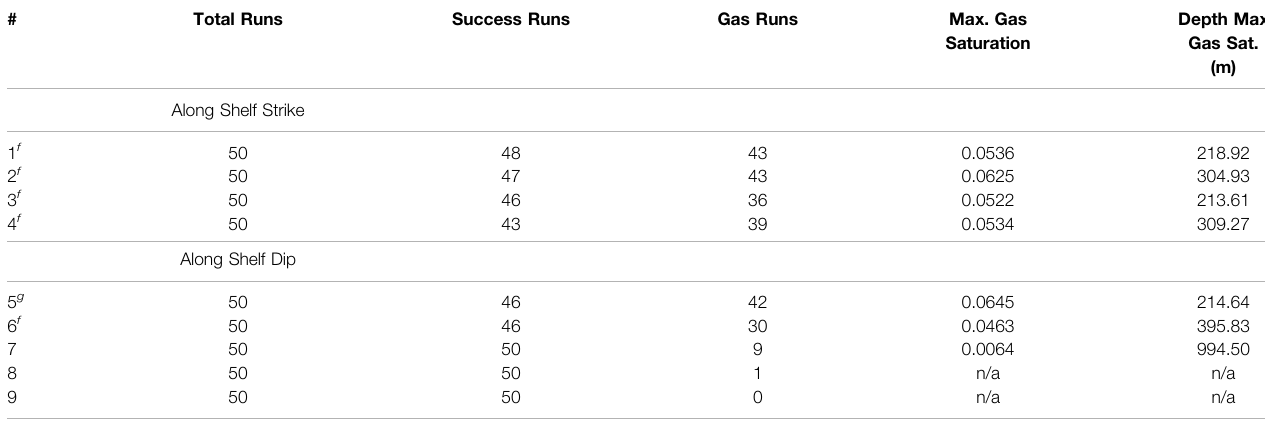
TABLE 5 | Summary of gas pro fi les modeled with PFLOTRAN and Dakota (gas locations g and feather edge locations f ).